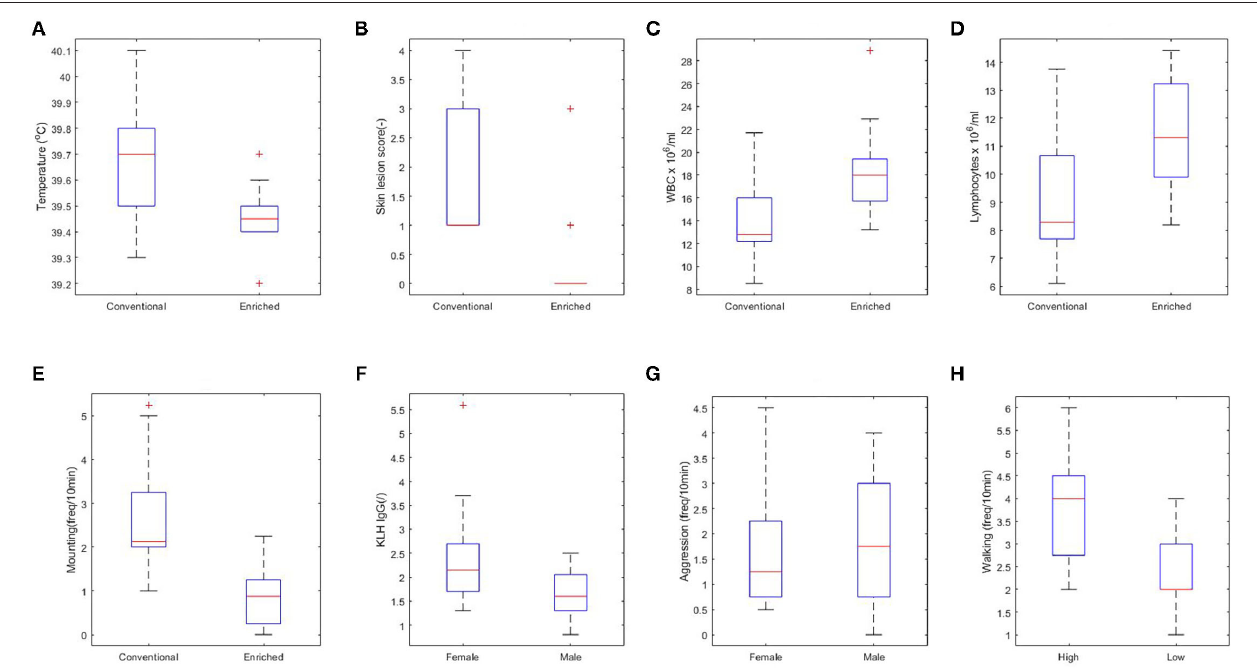
FIGURE 4 | Significant relations between housing (A–E) , sex (F,G) , and coping strategy (H) and explanatory variables. (A) Rectal body temperature at day 40 ( p < 0.01). (B) Skin lesions at the rear part of the body at day 38 ( p < 0.001). (C) White blood cell (WBC) at day 44 ( p < 0.05). (D) Lymphocytes at day 44 ( p < 0.05). (E)